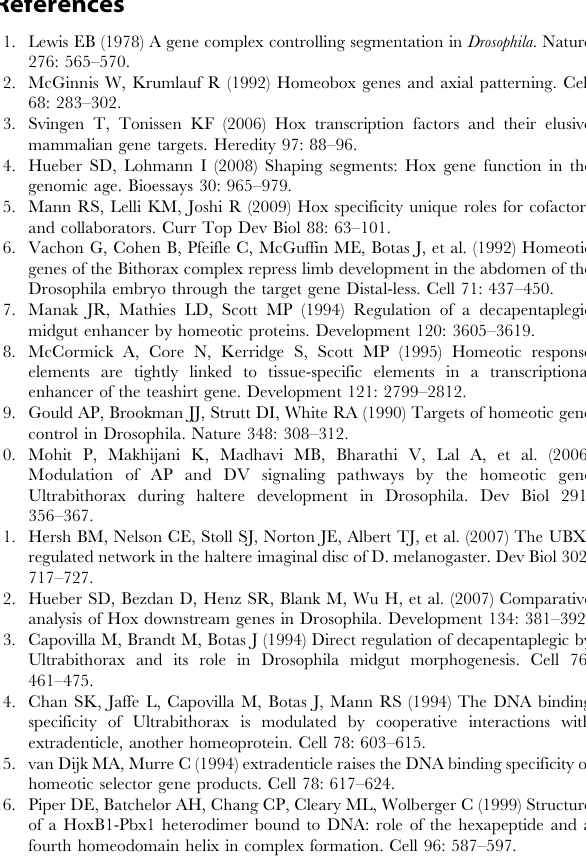
Table S1 Number of bound regions across the genome and unique genes associated with bound regions for each of the proteins in the indicated chromatin source at a range of false discovery rates. For analysis of Ubx target genes the 1181 genes at 1% FDR in haltere disc chromatin were used however the histone gene repeats were removed giving a total of 1147 genes (see Table S2). Comparison of numbers of bound regions or gene sets across different chromatin sources is difficult due to signal/noise differences and consequent threshold effects. For a direct comparison of Hth and Ubx targets see Table 2.